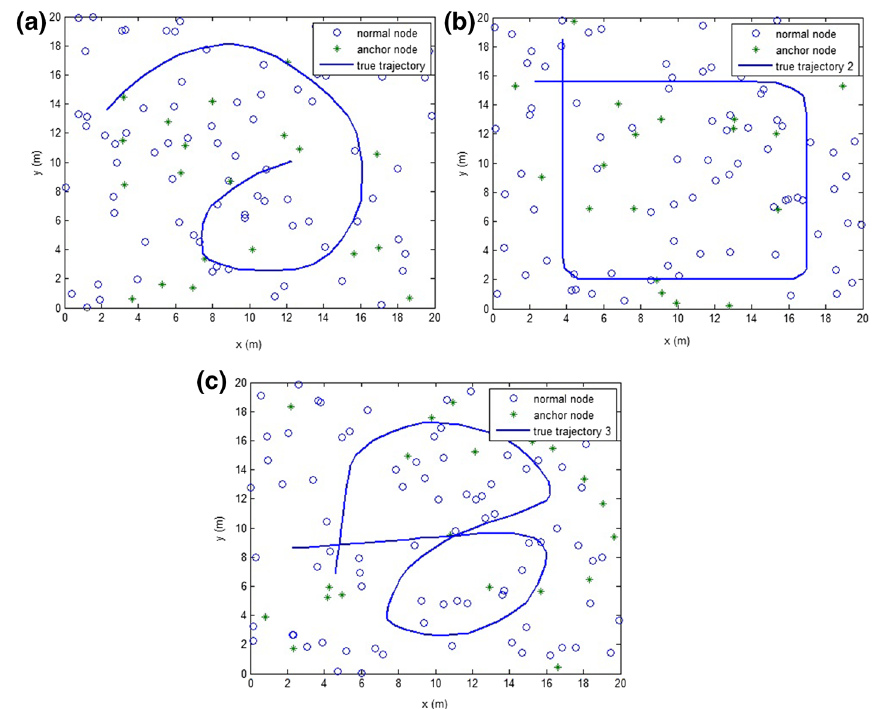
Fig. 3 True target trajectories. a A single target moves in a maneuvering trajectory without any intersection; b a single target moves in a maneuvering trajectory with one intersection and straight-line part; c a single target moves in a maneuvering trajectory with two